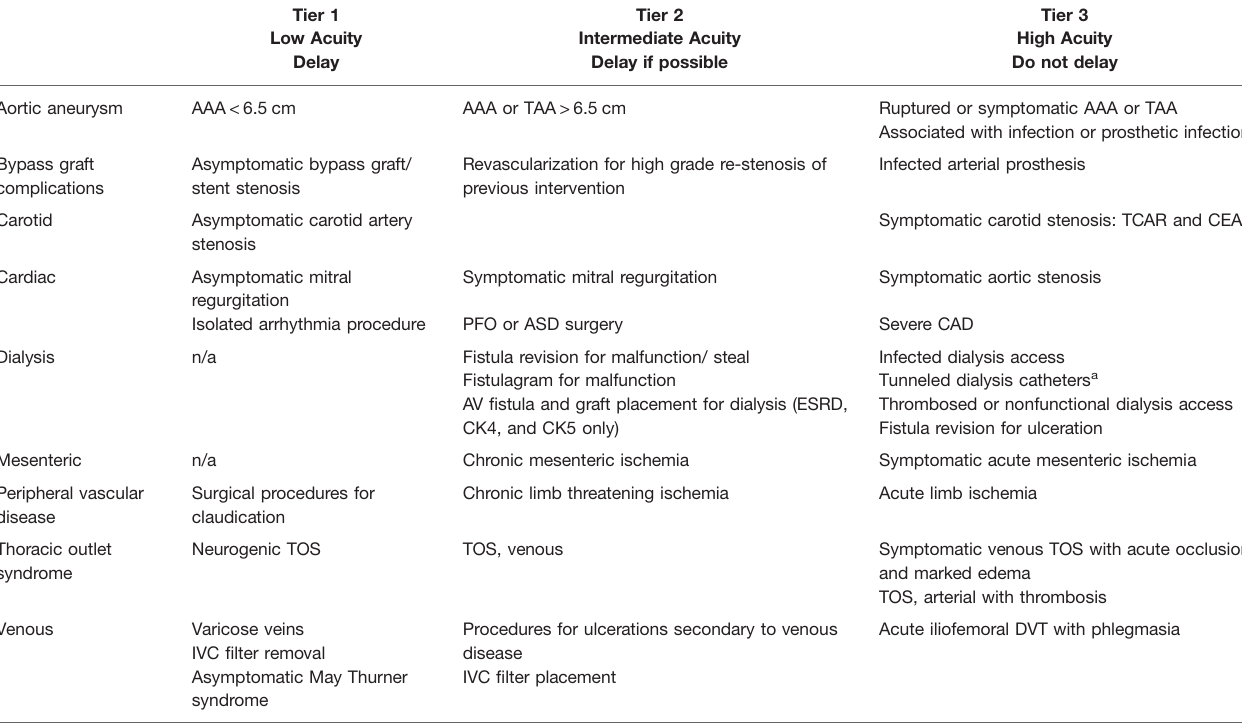
TABLE 6 | Cardiothoracic & Vascular Elective Surgery Acuity Scale (ESAS). All candidates for surgery should be assessed for surgical fi tness on an individual basis. This is an example ESAS and not comprehensive. Procedure acuity for the individual patient may shift among tiers based upon acuity of illness, severity of COVID- 19 infection and coagulopathy, and hospital surgical capacity (135, 140, 141). For speci fi c length of operative delay, please see the text and Association of Anesthesiologists guidelines (13).